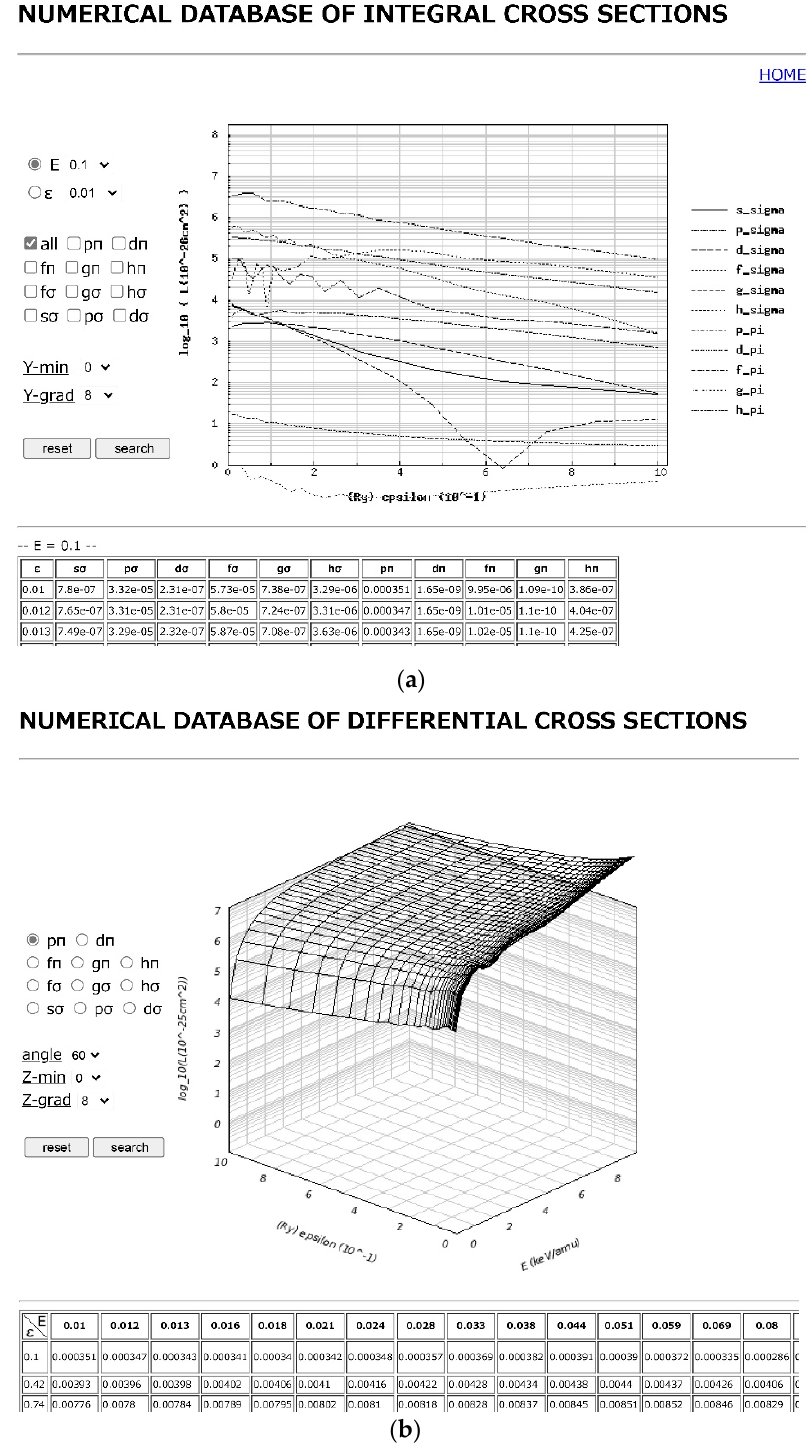
Figure 2. T ( a ) 2D graph of integral cross sections for ionization of atomic hydrogen by proton impact; ( b ) 3D graph of differential cross sections of atomic hydrogen by proton impact [36,37].